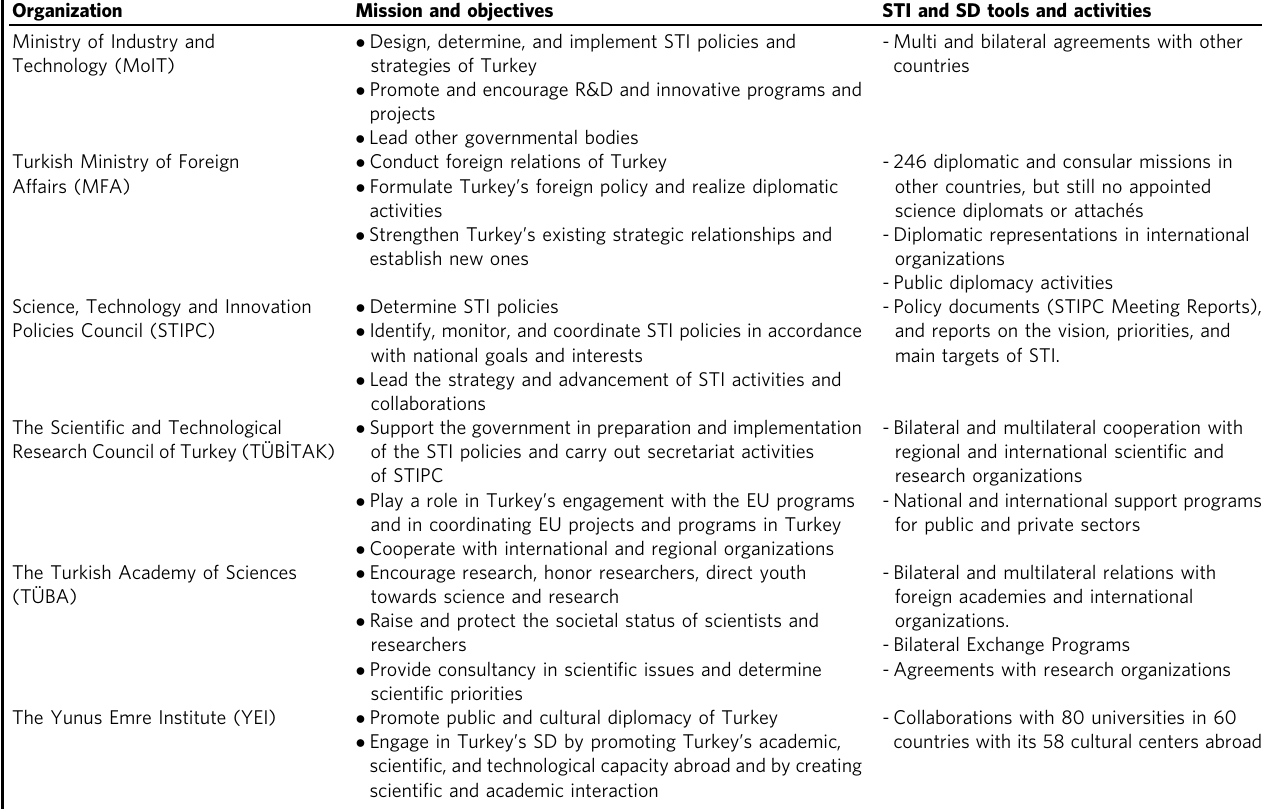
Table 1 The actors of SD in